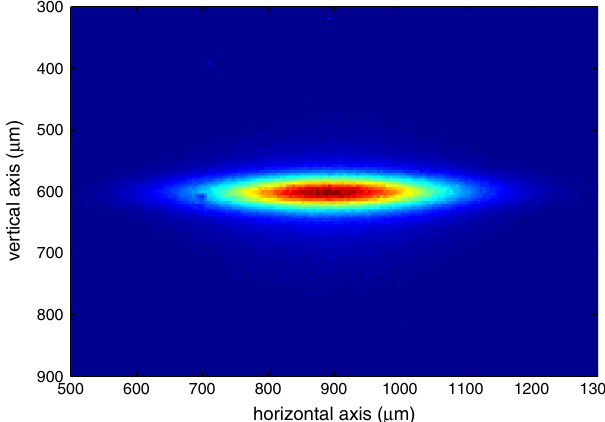
horizontal axis ( µ m) FIG. 14. (Color) Image from pinhole 1 with corrected optics for the storage ring, resulting in a low coupling and small beam size. The image beam size is 125 : 9 (cid:1) m horizontally and 20 : 9 (cid:1) m vertically.